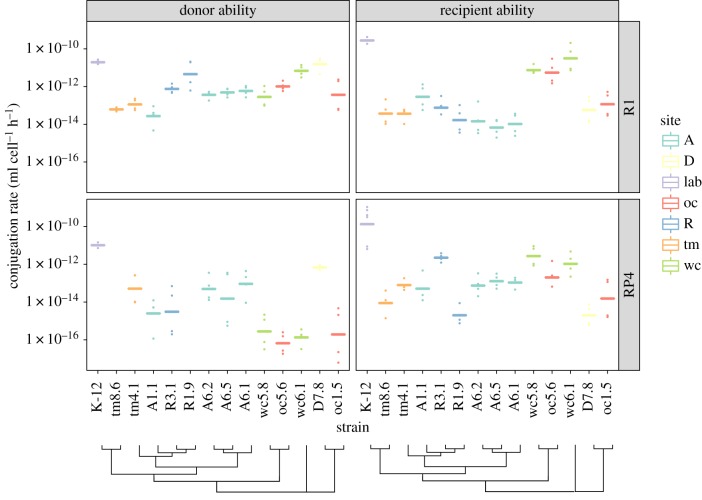
Extensive variation in plasmid donor and recipient ability across field isolates of Escherichia coli. Conjugation rates were measured in liquid with shaking over 3 h, towards K-12 MG1655 RifR (donor ability) and from K-12 MFDpir (recipient ability). Individual replicates are shown as dots, lines are geometric means. Rates with K-12 as both donor and recipient are shown on the left; field isolates are then ordered by their phylogenetic distance to K-12. Colour indicates site of origin for each isolate. A tree showing phylogenetic relationships is shown under strain names.